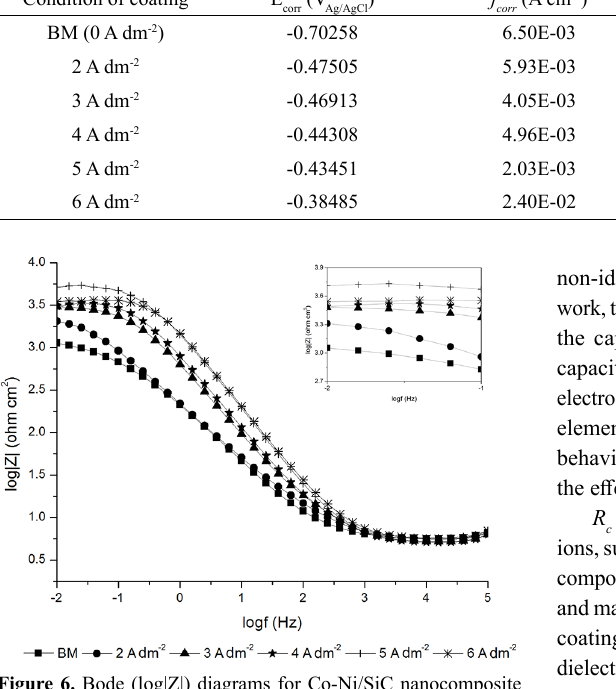
Table 4. Corrosion characteristic obtained from potentiodynamic polarization measurement for Co-Ni/SiC nanocomposite coatings and base metal. Condition of coating